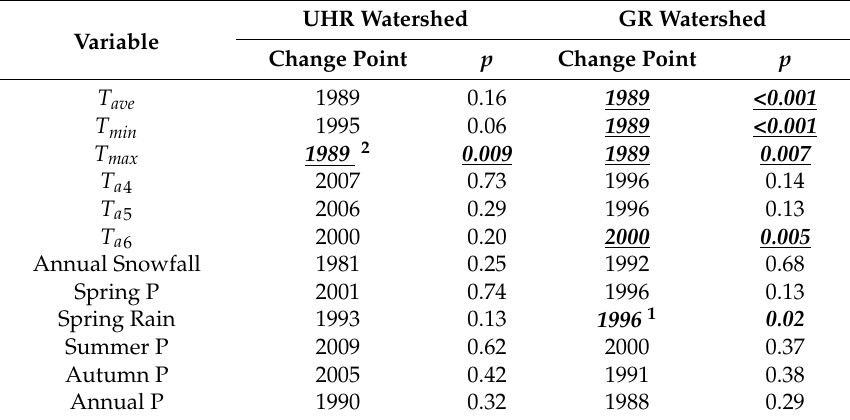
Table 6. Results of change point analysis on climatic variables from Pettitt’s test.